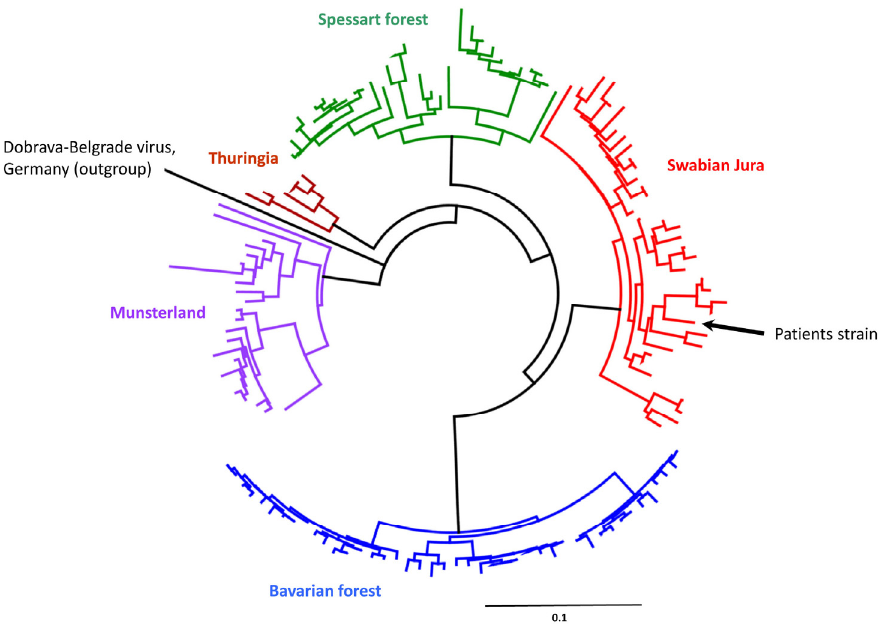
Figure 2. Phylogenetic analysis of partial PUUV L segment sequences in representative samples referred to us (Institute of Virology, Charité Universitätsmedizin Berlin) in our responsibility as the German National Consultant Laboratory for hantaviruses. Colors indicate phylogeographic clusters. Maximum likelihood (ML) tree based on a 345 nt alignment, calculated using the HKY85 +G +I model of nucleotide substitution. Scale bar indicates nucleotide substitutions per site. Sequence marked with an arrow stems from the patient described here. A Dobrava-Belgrade hantavirus sequence derived from an infected patient in Germany served as the outgroup.